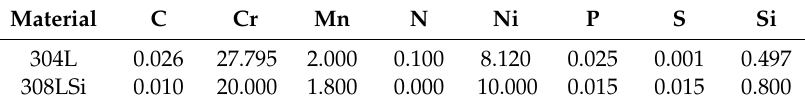
Table 1. Chemical composition of the stainless steel materials used for